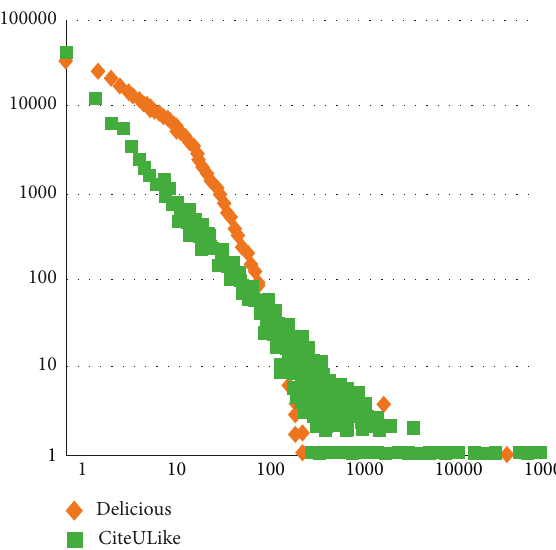
Figure 6: Activity distribution of students’ ideological and political courses in higher vocational